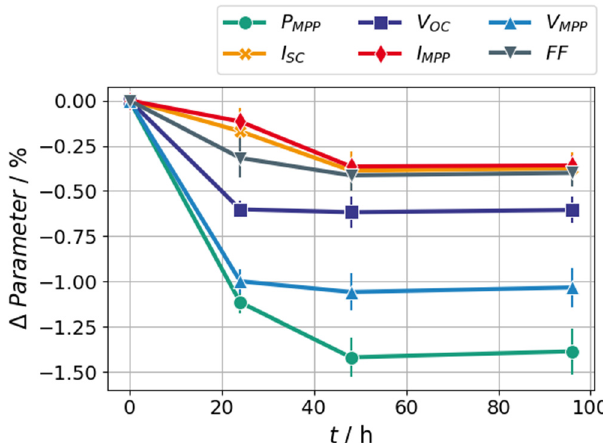
Fig. 5. Relative changes of the STC performance parameters of modules M04, M05 and M08 (cid:3) M13 due to BO LID preconditioning at 25 ° C and I SC . Average values over all modules; Error bars: standard